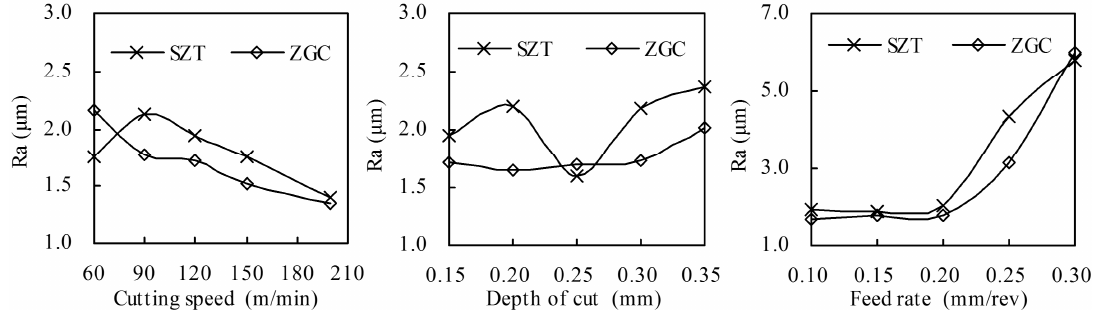
Figure 11. Ra of the machined surface at different cutting conditions (cutting distance L = 300 m).